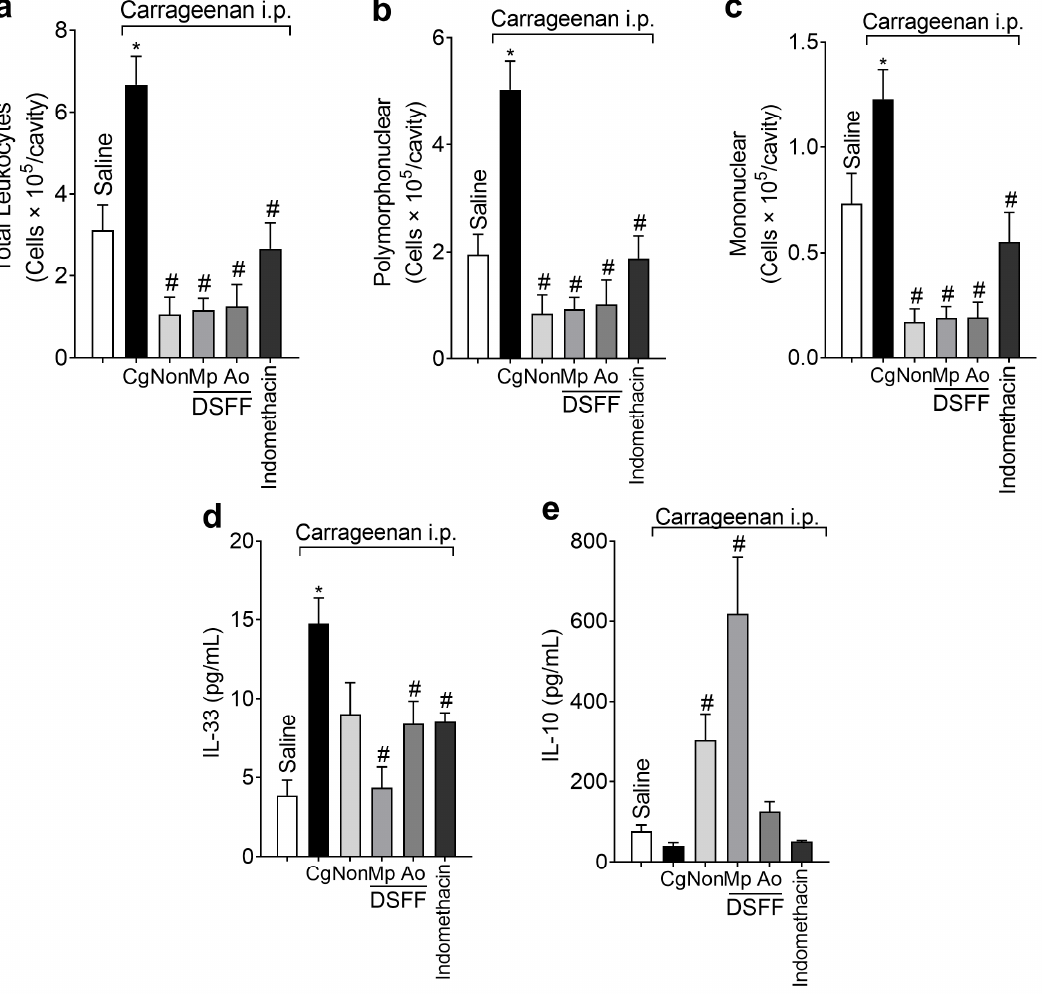
Figure 5. Evaluation of total and differential cell count and cytokine production in carrageenan peritonitis model. DSF-Non, DSFF-Mp, and DSFF-Ao (30 mg/kg) extracts inhibits ( a ) total leucocytes, and ( b ) polymorphonuclear, and ( c ) mononuclear cells in the perito- neal lavage. ( d ) IL-33 and ( e ) IL-10 levels. Indomethacin (5 mg/kg) was used as a positive control drug. Leukocyte recruitment and cytokine production were determined 5 h after carrageenan i.p. injection. Results are expressed as mean ±SEM of six mice per group per experiment and are representative of two independent experiments. * p < 0.05 vs. saline group; # p < 0.05 vs. carrageenan group. We further investigated potential mechanism differences among the three extracts in carrageenan peritonitis. We assessed whether the treatments with the extracts could re- duce the recruitment of CD45 + hematopoietic cells, and next, whether they could target the nuclear levels of phosphorylated (p) NF κ B (active form of the transcription factor NFkB) (Figure 6). DSF-Non, DSFF-Mp, and DSFF-Ao extracts all inhibited the recruitment of CD45 + cells triggered by carrageenan stimulus injection into the peritoneum (Figure 6a,b). This result agrees with the evidence that blood leukocytes of hematopoietic lineages